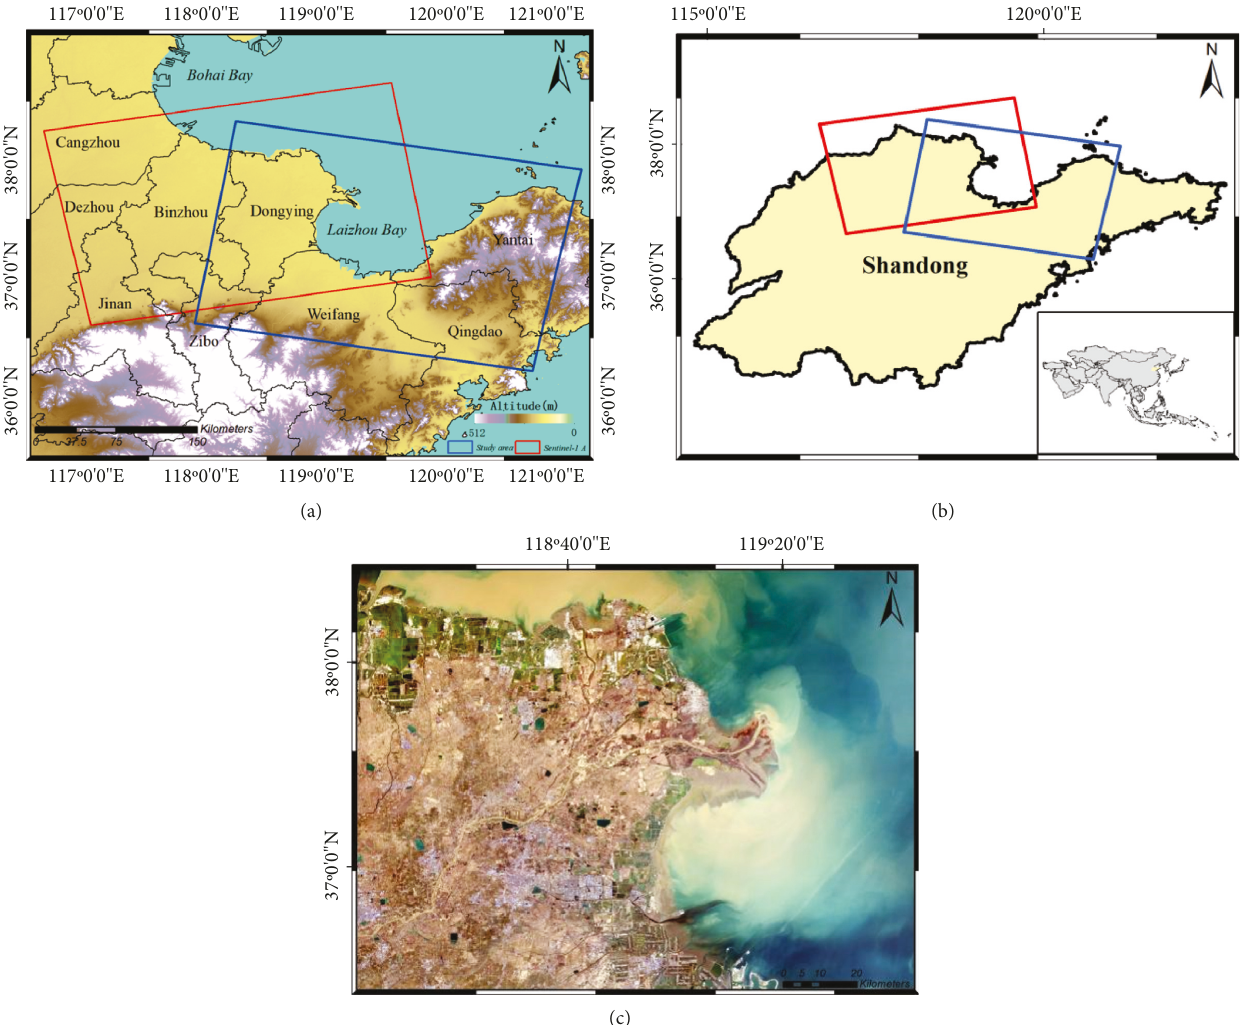
Figure 1: Location of the study area. (a) SRTM DEM 90m image of the study area, the red box denotes the Sentinel-1A range, and the blue box denotes the Sentinel-1B range; (b) the study area in Shandong Province, China, Asia; (c) the Landsat 8 image of part of the study